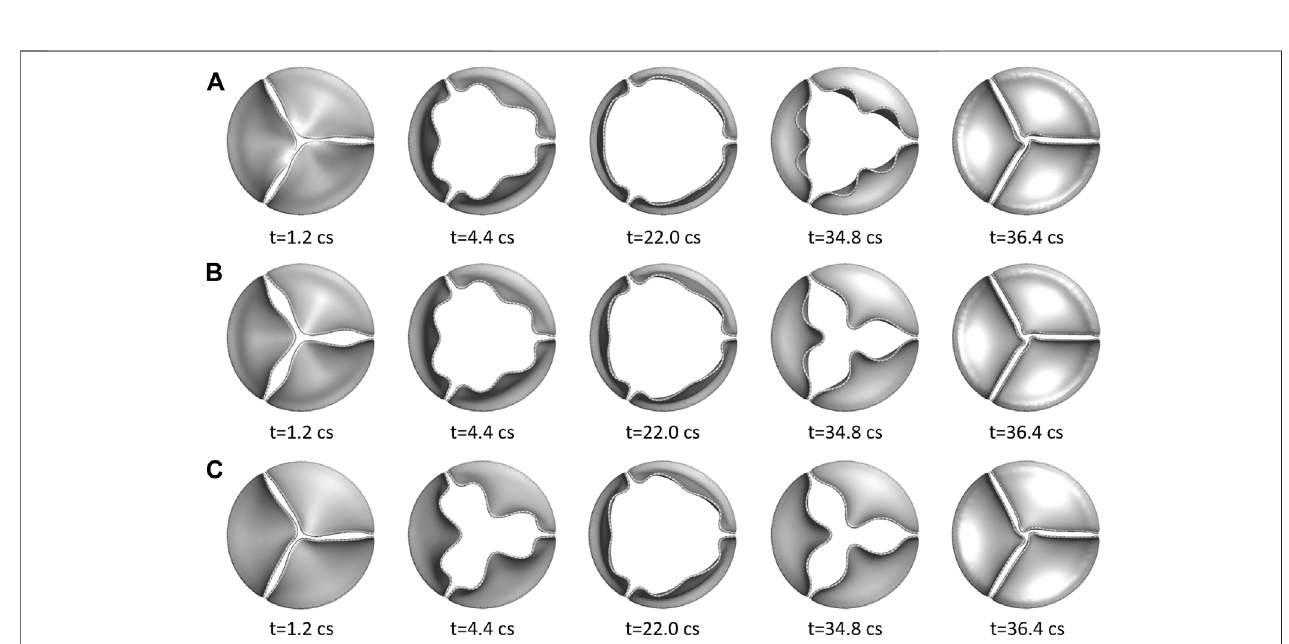
FIGURE 5 | Three rows show the opening and closing phases of the three aortic valves at multiple time instants: (A) E = 375 kPa; (B) E = 750 kPa; and (C) E = 1500 kPa.